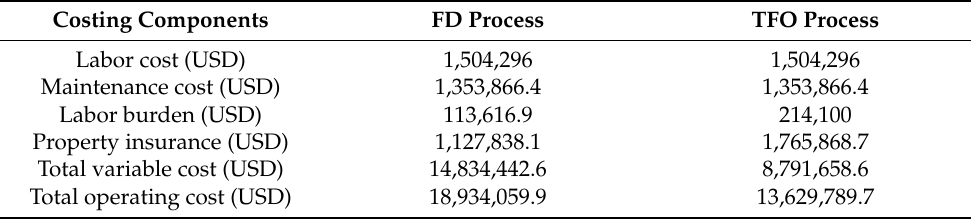
Table 7. The minimum selling price (MSP) of AA generated by the processes considered.